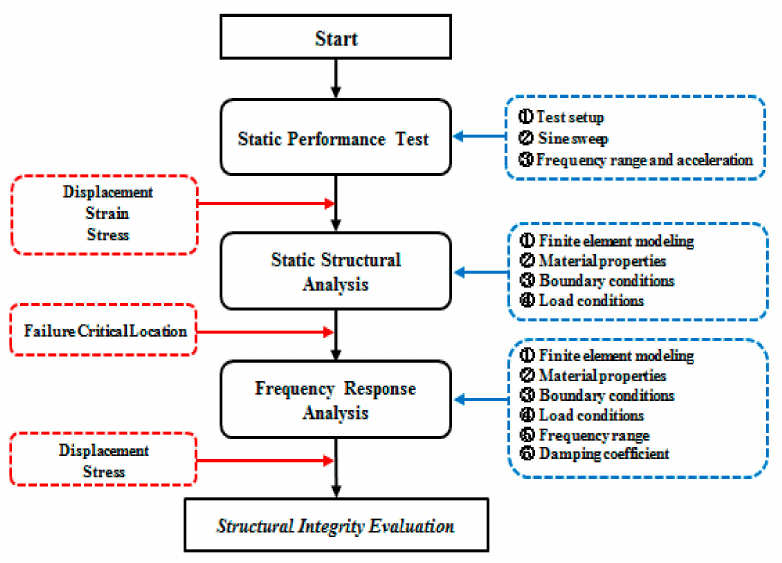
Figure 1. Flowchart for structural performance.